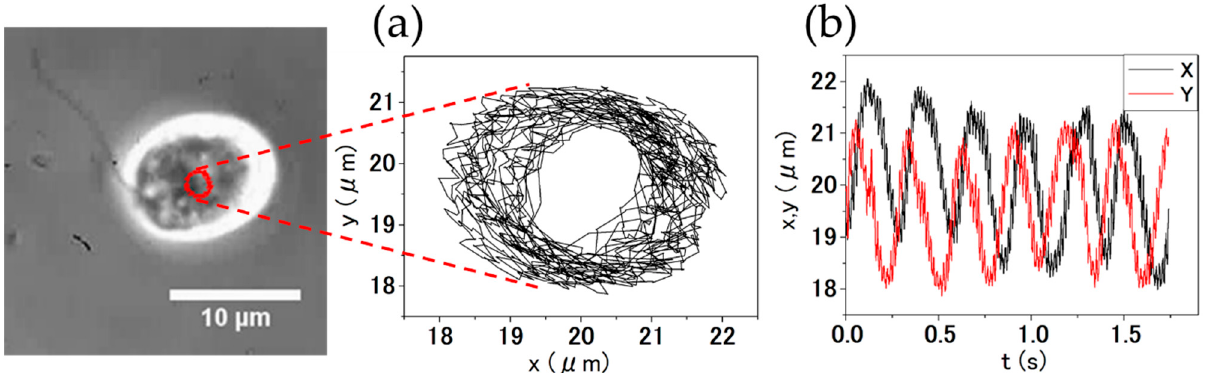
Figure 11. Revolution motion analysis of C. reinhardtii with only one flagellum. ( a ) XY plot of the revolution motion of C. reinhardtii . ( b ) Displacement of the center of revolving C. reinhardtii . Black represents the X coordinate of the center of C. reinhardtii , and red represents the Y coordinate of the center.